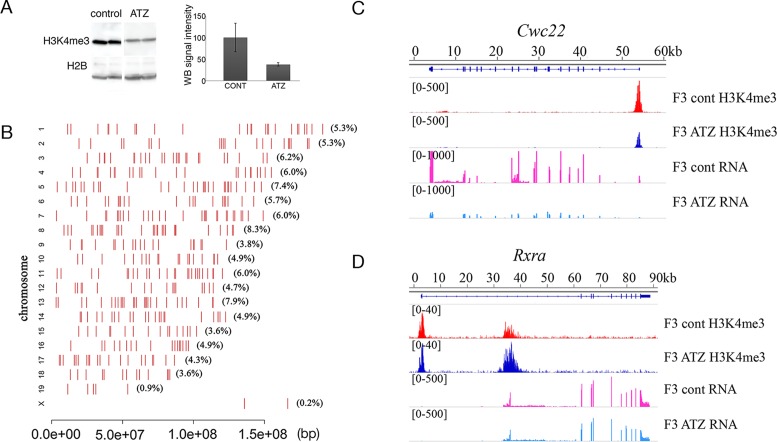
Histone H3K4me3 occupancy is globally affected in the third generation after treatment. (A) The decrease in histone H3K4me3 protein levels in treated mice. Histones were purified from F3 ATZ-derived and control male testes and equal amounts of proteins were analyzed by Western blot as described in the ‘Materials and Methods’ section. The control and ATZ samples were run in the same gel. (B) The altered genome-wide histone H3K4me3 peak occupancy in F3 ATZ-derived males. The red bars represent the position on the chromosome and the proportion of altered peaks per chromosome is indicated in brackets. (C) The occupancy of H3K4me3 marks (FC = 0.33) and transcription level (FC = 0.08) for the Cwc22 gene were both decreased in the third-generation males after exposure, (D) Despite the increased H3K4me3 occupancy (FC = 3) of ATZ-derived mice, the RNA transcript level of Rxra is not altered in ATZ F3 males. Histone H3K4me3 peaks were identified as described in the ‘Materials and Methods’ section and are expressed as a normalized tag number at each position. The RNA profile is shown as vertical bars (exons), and the values at each position were calculated as described in the ‘Materials and Methods’ section. H3K4me3 and RNA profiles were visualized using IGV genome viewer version 2.3.36.